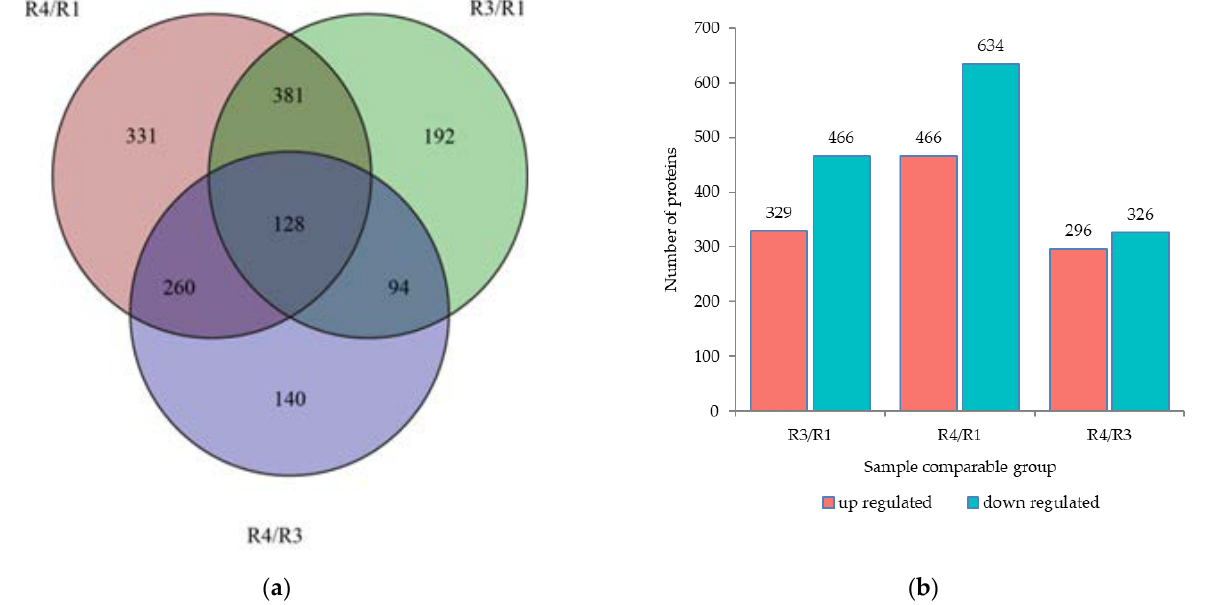
Figure 3. Distribution of DEPs in three comparison groups. ( a ) Distribution of DEPs in three comparison groups. ( b ) Ex- pression trends of DEPs in three comparison groups.